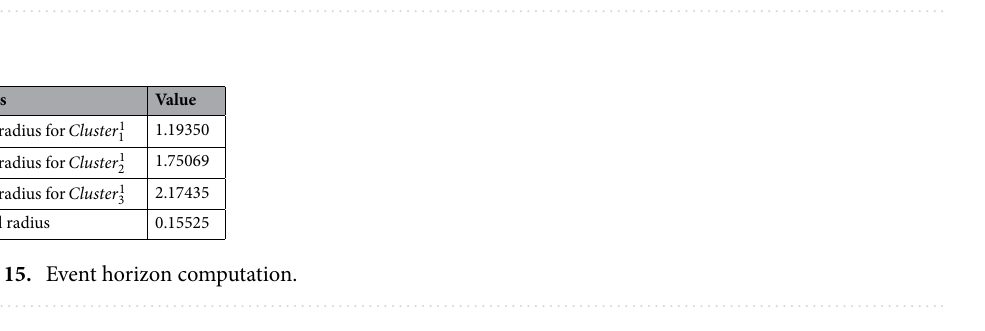
Table 14. Global best candidate ( ξ